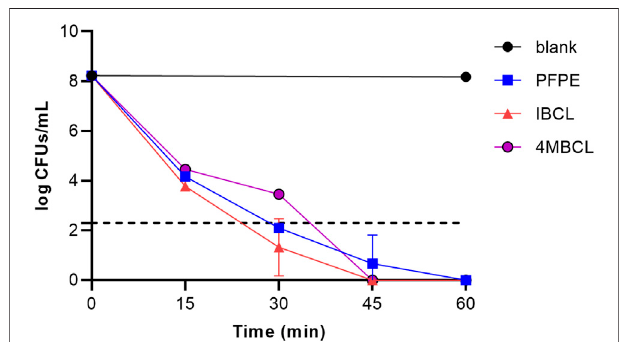
FIGURE 4 | Killing kinetics of PFPE (4 × MIC, 32 μ g/ml), IBCL (4 × MIC, 16 μ g/ml), and 4MBCL (4 × MIC, 16 μ g/ml) against stationary-phase C.